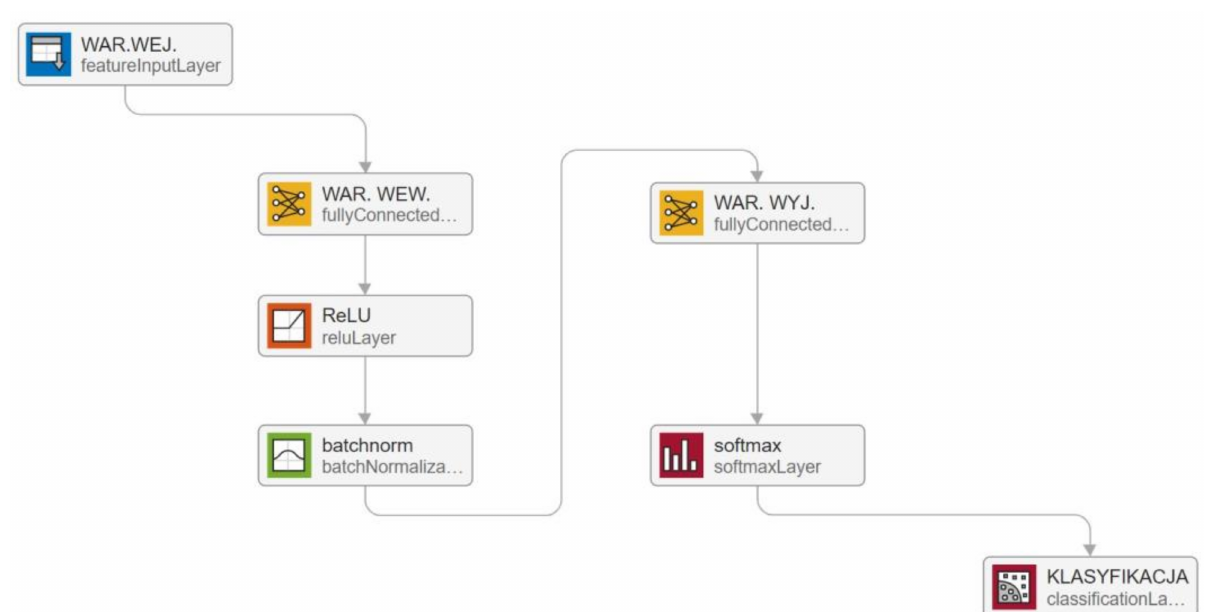
Figure 7. Block structure of the network adopted for the classification of the wear state of the studied pump